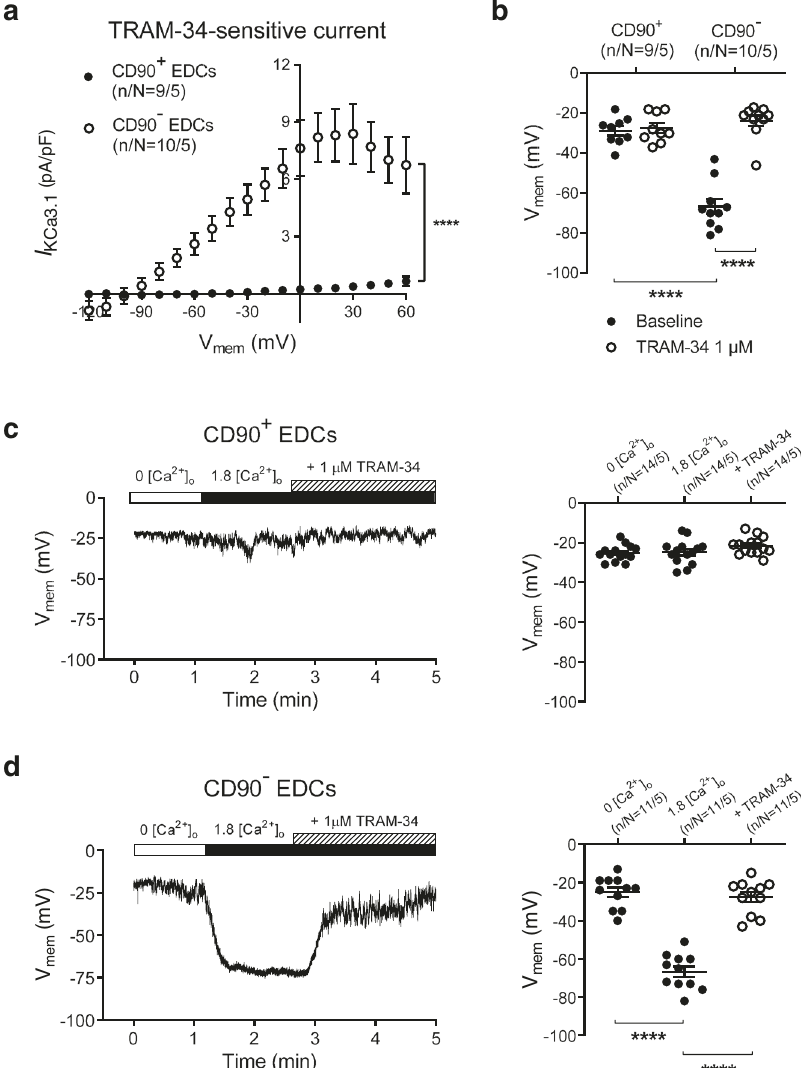
Fig. 2 Functional endogenous KCa3.1 current and membrane-potential changes during SOCE in EDCs. a . I – V relationship of I KCa3.1 (TRAM-34 – sensitive current) in CD90 + and CD90 − EDCs. Data are mean ± SEM; n/N = cells/cell lines per group. b Resting potential of EDCs before and after exposure to 1 µ mol/L TRAM-34. Two-way repeated-measures ANOVA with individual-mean comparisons by Bonferroni-corrected two-sided t -tests; n/N = cells/cell lines per group. Data are individual points along with mean and SEM. c Original current-clamp recording from one CD90 + cell (left panel) and mean ± SEM data for V mem changes induced by SOCE (resulting from intracellular Ca 2 + -depletion by exposure to nominally Ca 2 + -free extracellular Ca 2 + (0 [Ca 2 + ] o ) and then reintroduction of 1.8 mmol/L Ca 2 + (1.8 [Ca 2 + ] o )), with subsequent exposure to 1- µ mol/L TRAM-34 (right panel). d Original current-clamp recording from one CD90 − cell (left panel) and mean ± SEM data for V mem changes induced by SOCE and subsequent exposure to 1 µ mol/L TRAM-34 (right panel). One-way ANOVA with individual-mean comparisons by Bonferroni-corrected two-sided t -tests; numbers shown on bars are numbers of cells studied; n/N = cells/cell lines per group; Open circles = CD90 − , closed circles = CD90 + . EDC explant-derived cell, min minutes, V me membrane potential. **** P < 0.0001. For precise P values, see Supplemental Source Data and Statistics fi